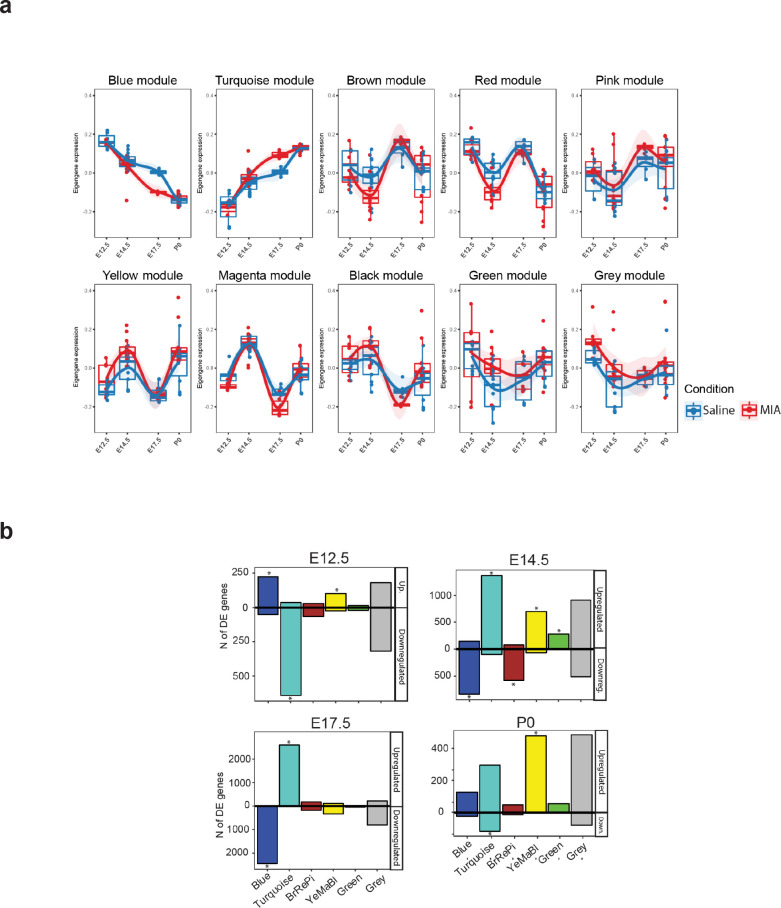
Summary of WGCNA module eigengene expression, association with experimental variables, and overlap with DE genes.(a) Eigengene trajectories across neurodevelopment of the ten original co-expression modules. (b) DE (p < 0.05) gene set enrichment analysis in WGCNA modules across the developmental time-points of the study. Values representing the number of upregulated and downregulated genes are plotted above and below 0, respectively. Asterisks indicate statistically significant enrichment of DE genes (p < 0.05) in a module (p < 0.05; hypergeometric test).